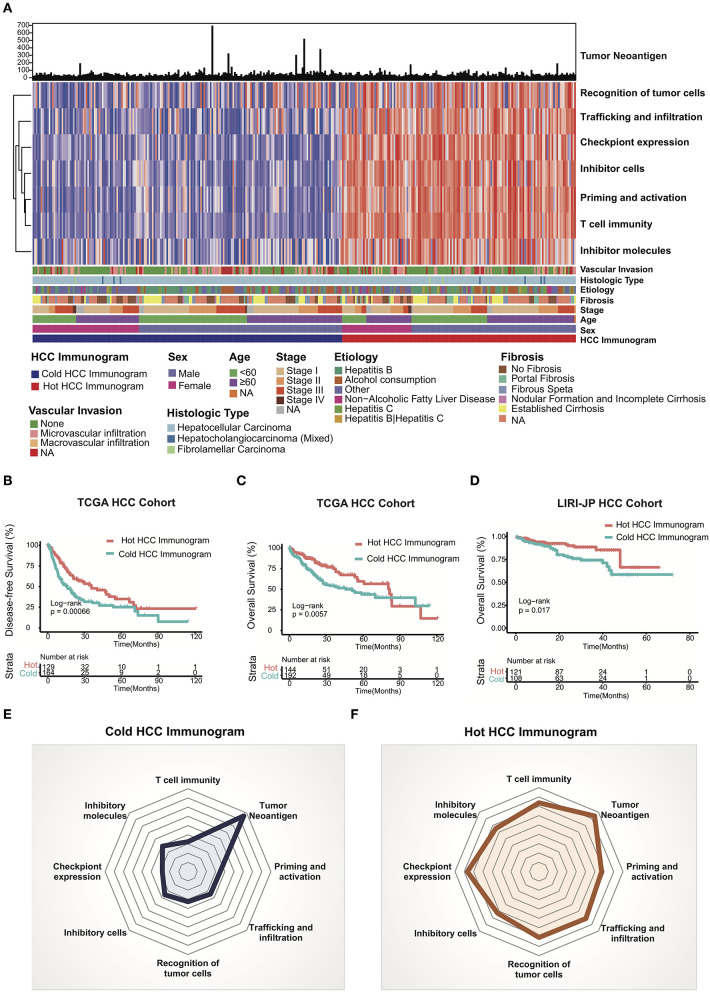
HCC cancer immunogram and prognosis. (A) Unsupervised clustering analysis of HCC immunograms based on eight axes of the IGS for 337 patients in the TCGA HCC cohort. The higher IGS cluster was termed the hot HCC immunogram, and the lower IGS cluster was termed the cold HCC immunogram. The clinical features, including age, sex, stage, fibrosis, etiology, histological type, and vascular invasion, are shown in patient annotations. (B) Kaplan–Meier curves for DFS of HCC patients in the TCGA cohort stratified into the two HCC immunogram clusters. The numbers of patients in the hot and cold immunogram clusters were 129 and 164, respectively. The log-rank test showed P = 0.00066. (C) Kaplan–Meier curves for OS of HCC patients in the TCGA cohort stratified into the two HCC immunogram clusters. The numbers of patients in the hot and cold immunogram clusters were 144 and 192, respectively. The log-rank test yielded P = 0.0057. (D) Kaplan–Meier curves for OS of HCC patients in the LIRI-JP HCC cohorts stratified into the two HCC immunogram clusters. The numbers of patients in the hot and cold immunogram clusters were 121 and 108, respectively. The log-rank test yielded P = 0.017. (E,F) The radar plot showed that the immunogram patterns of the two clusters were distinct. The axes of the radar chart were generated with the median IGS for the hot and cold immunogram clusters, respectively.